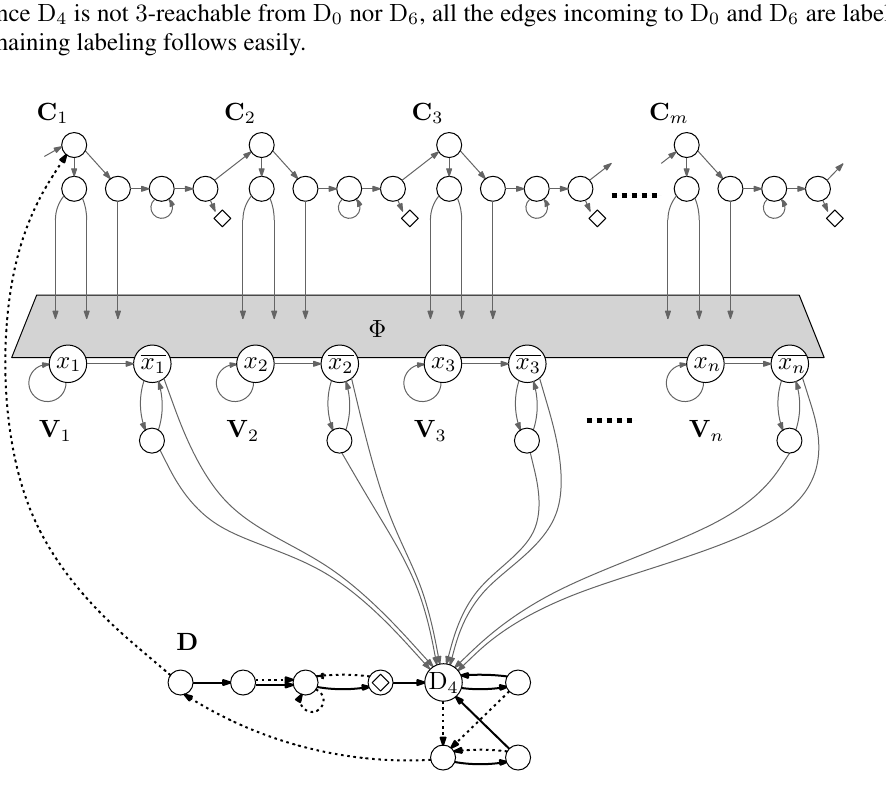
Fig. 6: The entire G Φ with the edges outgoing from D colored. Bold arrows: a , dotted arrows: b